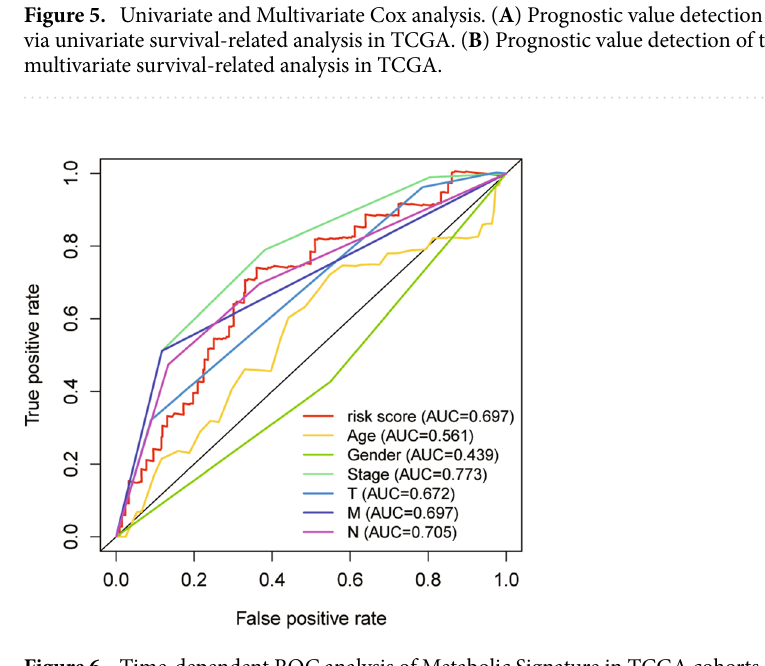
Figure 6. Time-dependent ROC analysis of Metabolic Signature in TCGA cohorts. ROC, receiver operating characteristic; AUC, area under the ROC